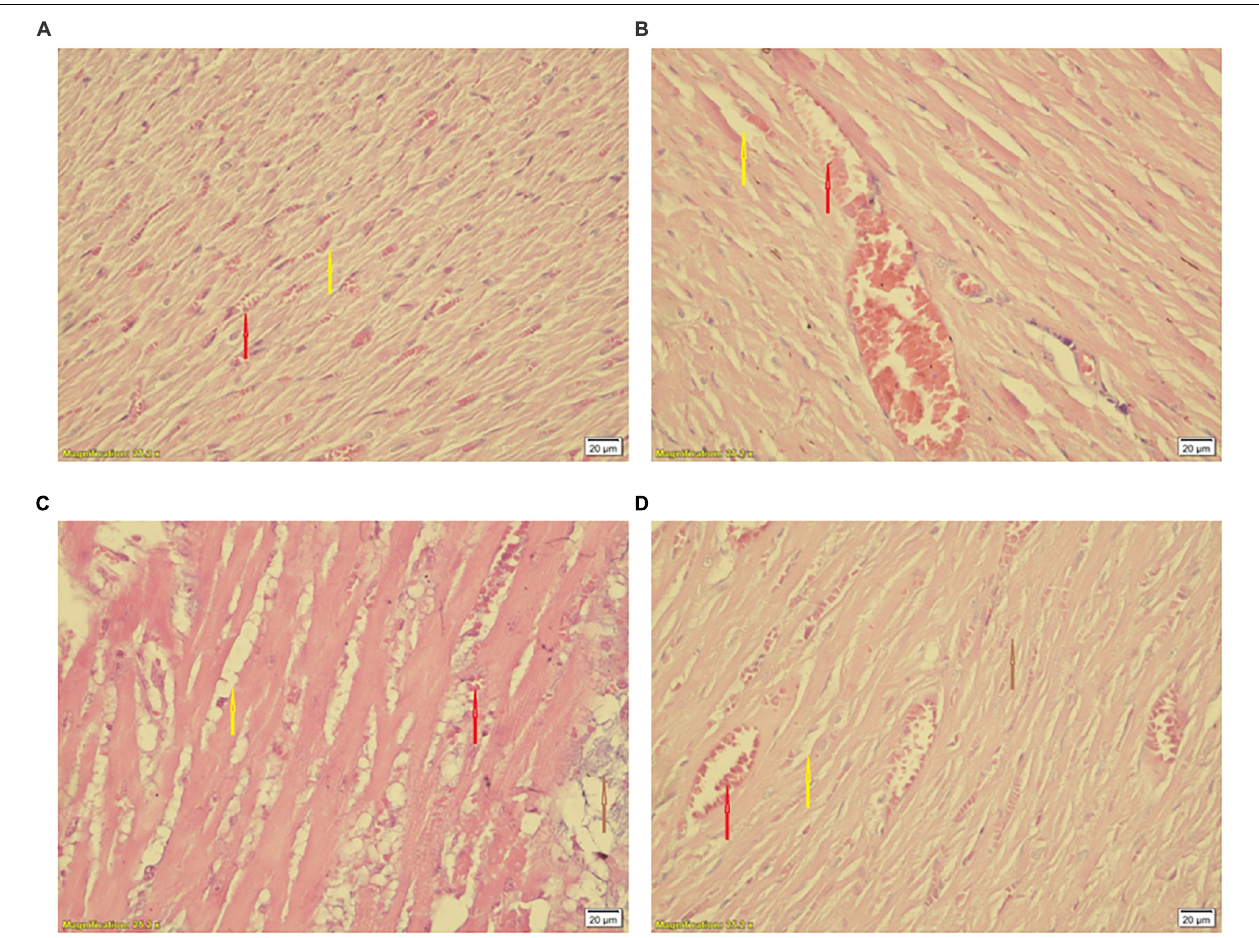
FIGURE 10 | Histological changes of the heart in experimental groups. (A) CTL, (B) Ex, (C) S, and (D) Ex + S. Heart tissues were stained with hematoxylin and eosin and visualized under a light microscope. CTL, control group; Ex, group subjected to exercise training for 8 weeks; S, group subjected to waterpipe tobacco smoke inhalation for 8 weeks; Ex + S, group subjected to exercise training and waterpipe tobacco smoke inhalation for 8 weeks. Histopathological examination was performed under light microscopy at a magnification of × 40. Yellow arrow: interstitial edema, red arrow: congestion, brown arrow: cellular